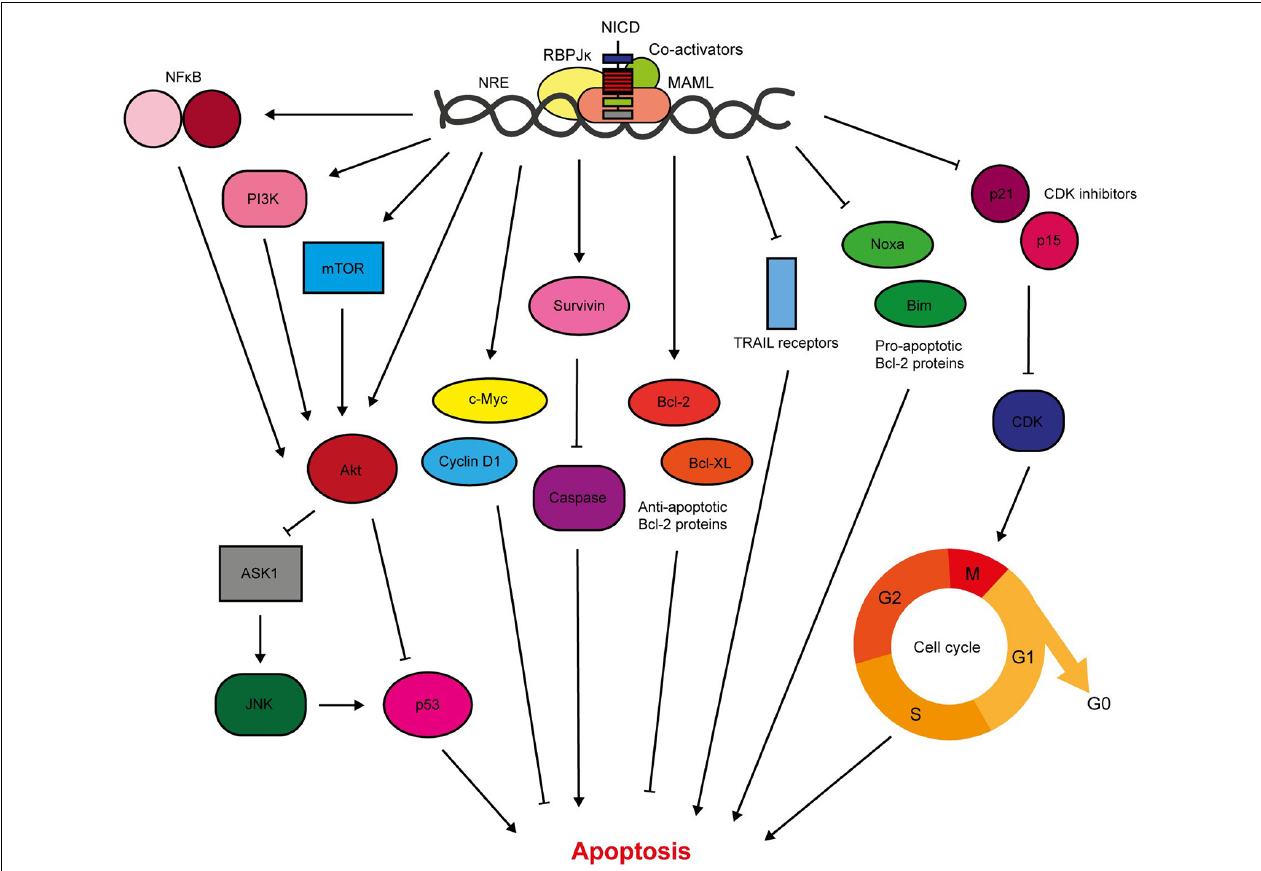
FIGURE 4 | Notch signalling inhibits breast cancer cell apoptosis. Notch activates pro-survival Akt signalling through NF κ B, PI3K, and mTOR signalling (Mungamuri et al., 2006; Osipo et al., 2008a; Efferson et al., 2010; Zang et al., 2010; Zhu et al., 2013; Li L. et al., 2014b; Hossain et al., 2018). Our lab have shown that Notch also stimulates Akt through a secreted factor, which triggers stabilisation of p53 through ASK1/JNK signalling (Meurette et al., 2009). The Notch target gene c-Myc is anti-apoptotic, and there is significant evidence demonstrating upregulation of survivin in response to Notch activation (Klinakis et al., 2006; Lee et al., 2008a,b). Survivin prevents apoptosis through indirect and direct caspase inhibition (Garg et al., 2016). Of the Bcl-2 family members, Notch upregulates the anti-apoptotic members including Bcl-2 and Bcl-X L , while downregulating pro-apoptotic members such as Bim and Noxa (Portanova et al., 2013; Sales-Dias et al., 2019). Active Notch signalling reduces the sensitivity of TNBC cells to TRAIL-induced apoptosis (Portanova et al., 2013). Notch regulation of cell cycle regulators, including cyclin D1, p21 and p15, also contributes to apoptosis resistance (Cohen et al., 2010; Sales-Dias et al.,